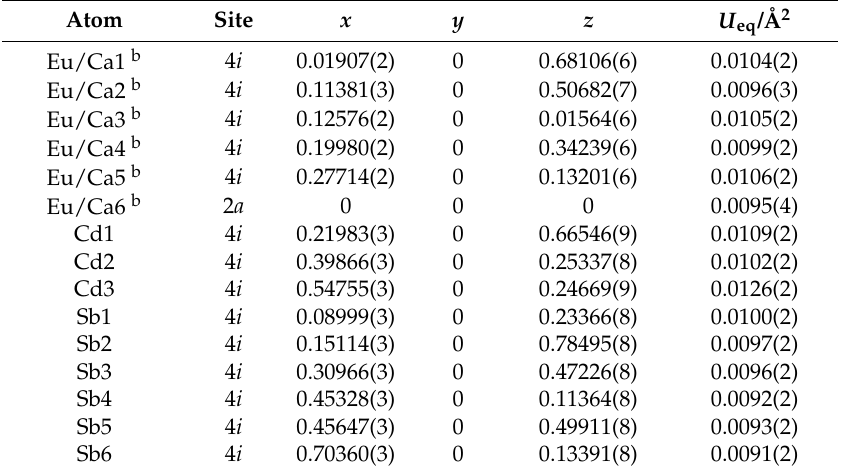
Figure 4. ( a ) Crystal structure of Eu 11 − x Ca x Cd 6 Sb 12 with Eu/Ca, Cd, and Sb atoms shown in orange, red, and blue, respectively; ( b ) variation of the Eu occupancy as a function of the available volume for the non-equivalent AE positions in Eu 10.01 Ca 0.99(1) Cd 6 Sb 12 ( AE = Eu + Ca). Table 7. Atomic coordinates and equivalent displacement parameters ( U eqa ) for Eu 11– x Ca x Cd 6 Sb 12 , x =